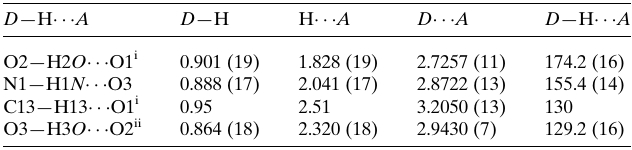
Table 1 Hydrogen-bond geometry (A˚ , (cid:4) ).